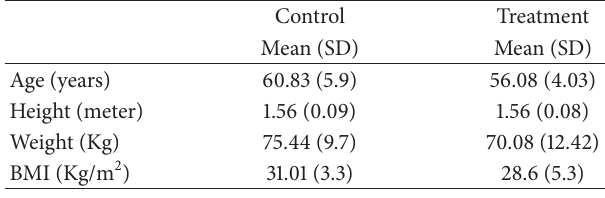
Table 1: Anthropometric information of all participants.